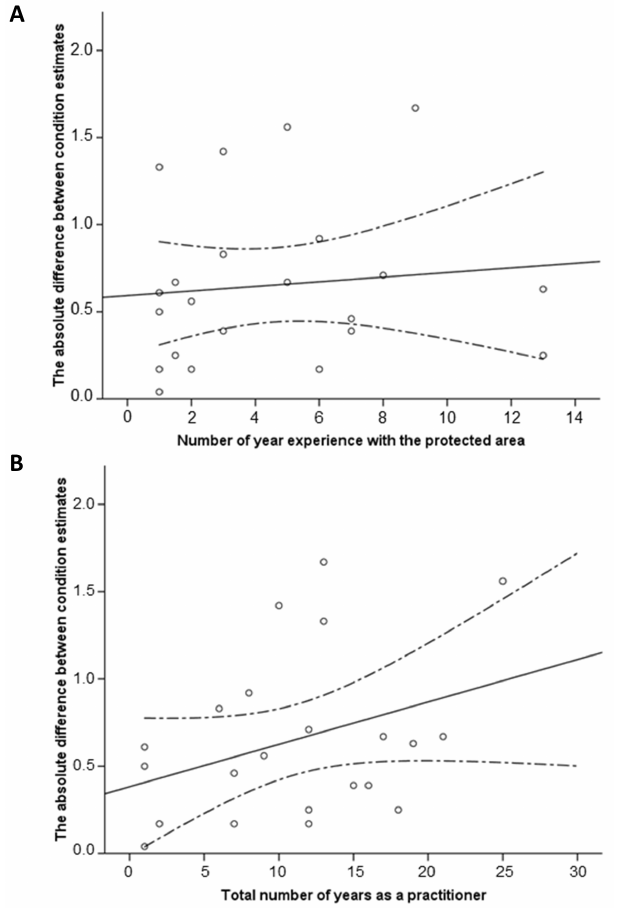
Fig. 4 . The relationship between a practitioners’ experience and the accuracy of their condition estimate based on: (A) number of years with the protected area being assessed, and (B) the total number of years as a practitioner (n = 19). The solid line indicates the linear relationship between the points and the broken lines indicate confidence intervals for the regression